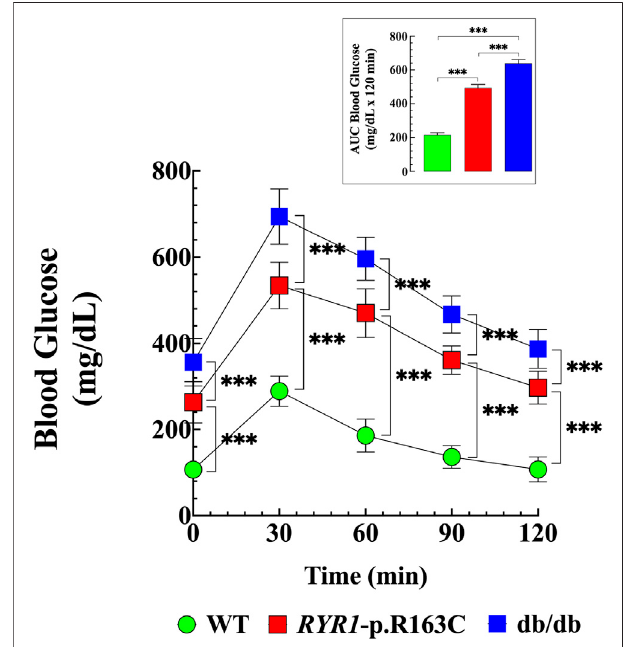
FIGURE 1 | Abnormal glucose tolerance in RYR1-p.R163C and db/db. GTTs were carried out in fasting WT, RYR1 -p.R163C, and db/db mice. Basal bloodglucoselevelswereelevatedin RYR1 -p.R163Canddb/dbcomparedto WT mice. A notable difference in average peak amplitude at 30 min was found in RYR1 -p.R163C and db/db compared to WT. The glucose tolerance was expressed as the AUC (Insert), which was calculated using the trapezoid rule over the 120-min test duration (GraphPad Prism software 9.0). Values are expressed as mean ± S. D; experiments were conducted in n mice = 6 per genotype. Statistical analysis was performed using a one-way analysis of variance (ANOVA) followed by Tukey ’ s multiple comparisons. *** = p <